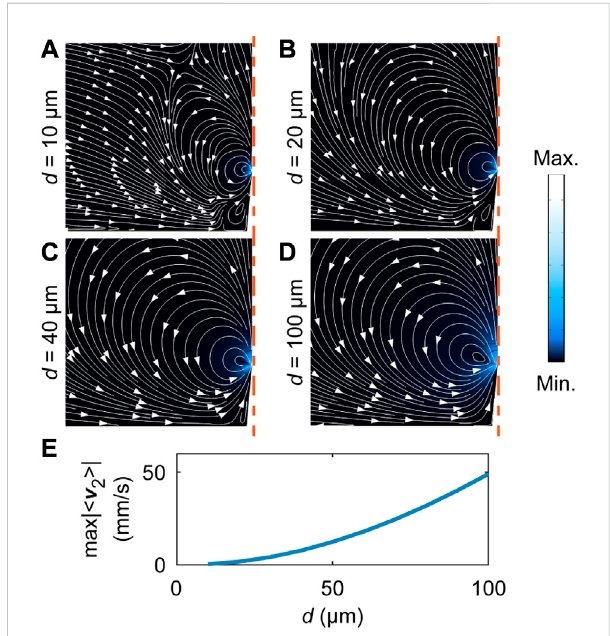
FIGURE 10 In fl uence of the channel depth d on the sharp-edge streaming pattern at the middle xy -plane (at z = d /2), studied with the Hybrid 3D model. The channel depth is varied from d = 10 µm in (A) to d = 100 µm in (D) at a fi xed frequency of f = 720 kHz. The corresponding maximal Eulerian streaming velocity | 〈 v 2 〉 | is shown in (E) . The channel contains a single sharp edge, as indicated in Figure 2, with h = 100 μ m, b = 150 μ m, α = 10 ° , and the sharp-edge rounding radiusof δ /2. (A) – (D) Eulerianstreamingvelocitymagnitude| 〈 v 2 〉 |.The excitation is imposed in the same direction (in phase) at x =± a /2, with an amplitude of v a = 1 mm s − 1